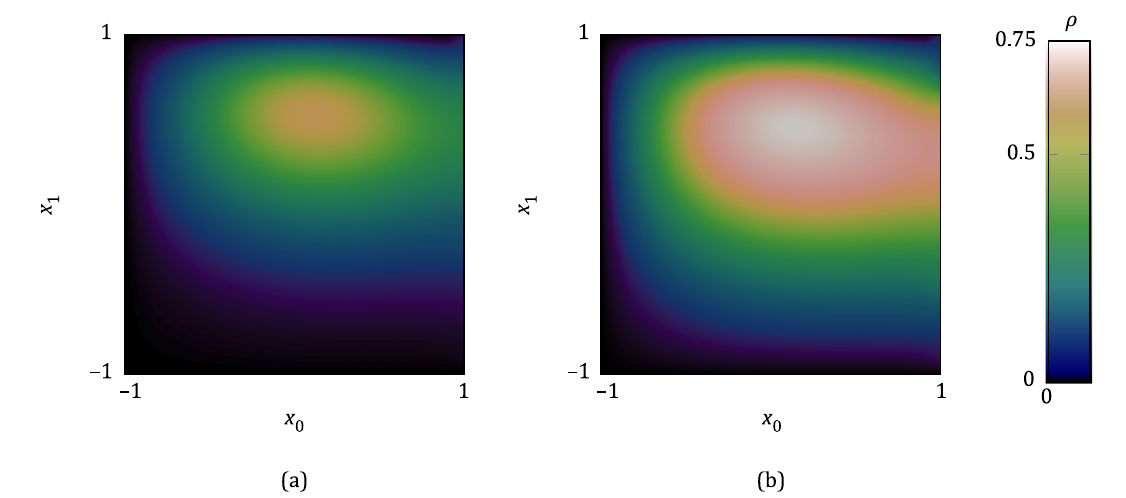
Figure 2. Illustration of the distribution of the scalar ρ seeded at the upper boundary after diffusion and convection (a) and additional reaction (b) as described in Test Cases 2 and 3 for N h = 15 at time t =